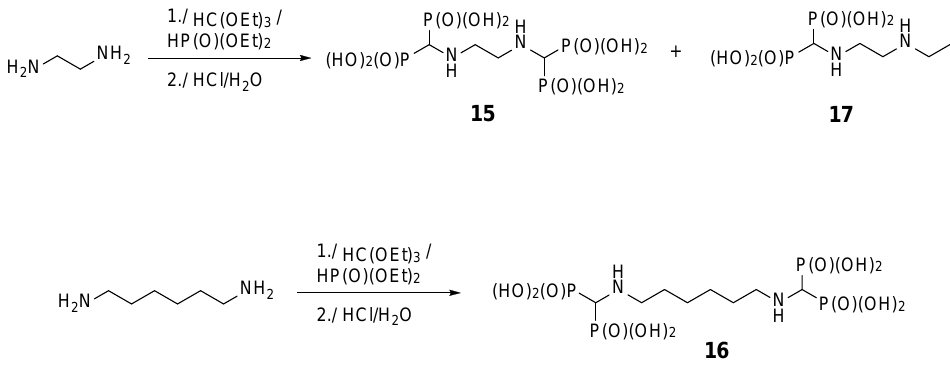
Figure 9. Products of the reactions of aminoalkylidenediamines.